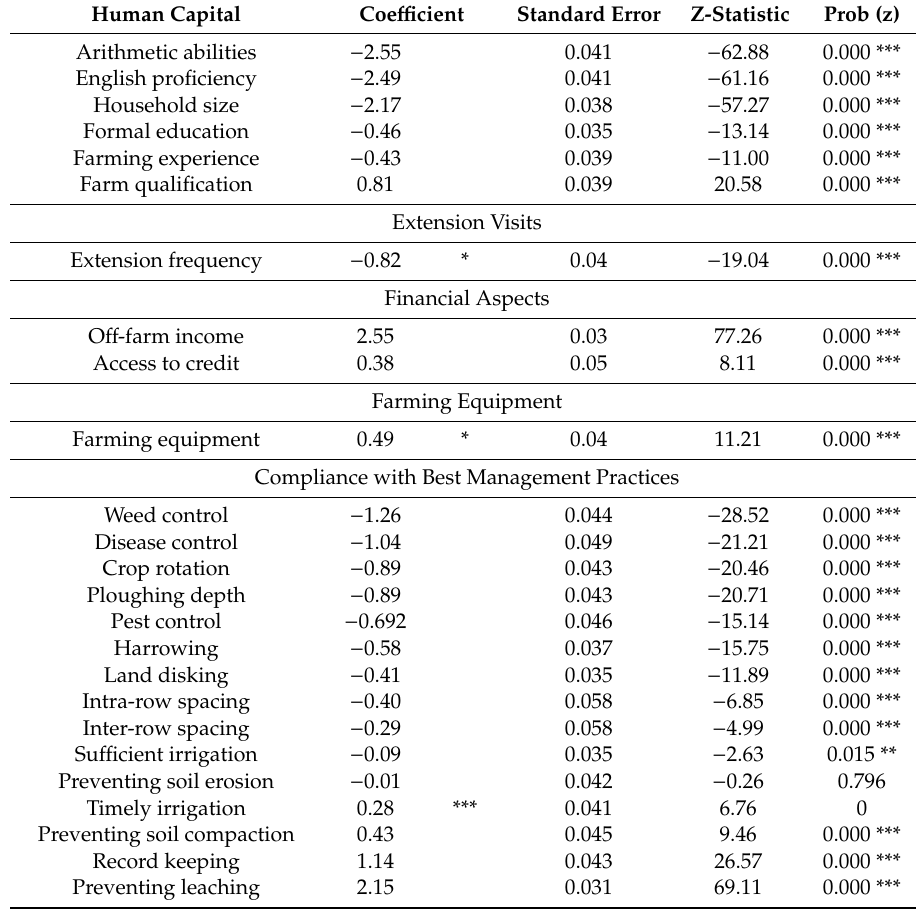
Table 3. Regression results from the truncated bias-corrected technical e ffi ciency